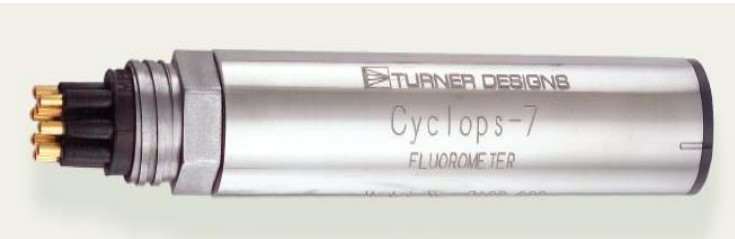
Figure 7. Cyclops-7 underwater fluorometer. For the in-water tests, the sampling rate of the fluorometer is set as 10 Hz, and the 0–10 μg/L measurement scale in which the fluorometer outputs 5 VDC corresponding to a rhodamine dye concentration of 10 μg/L is